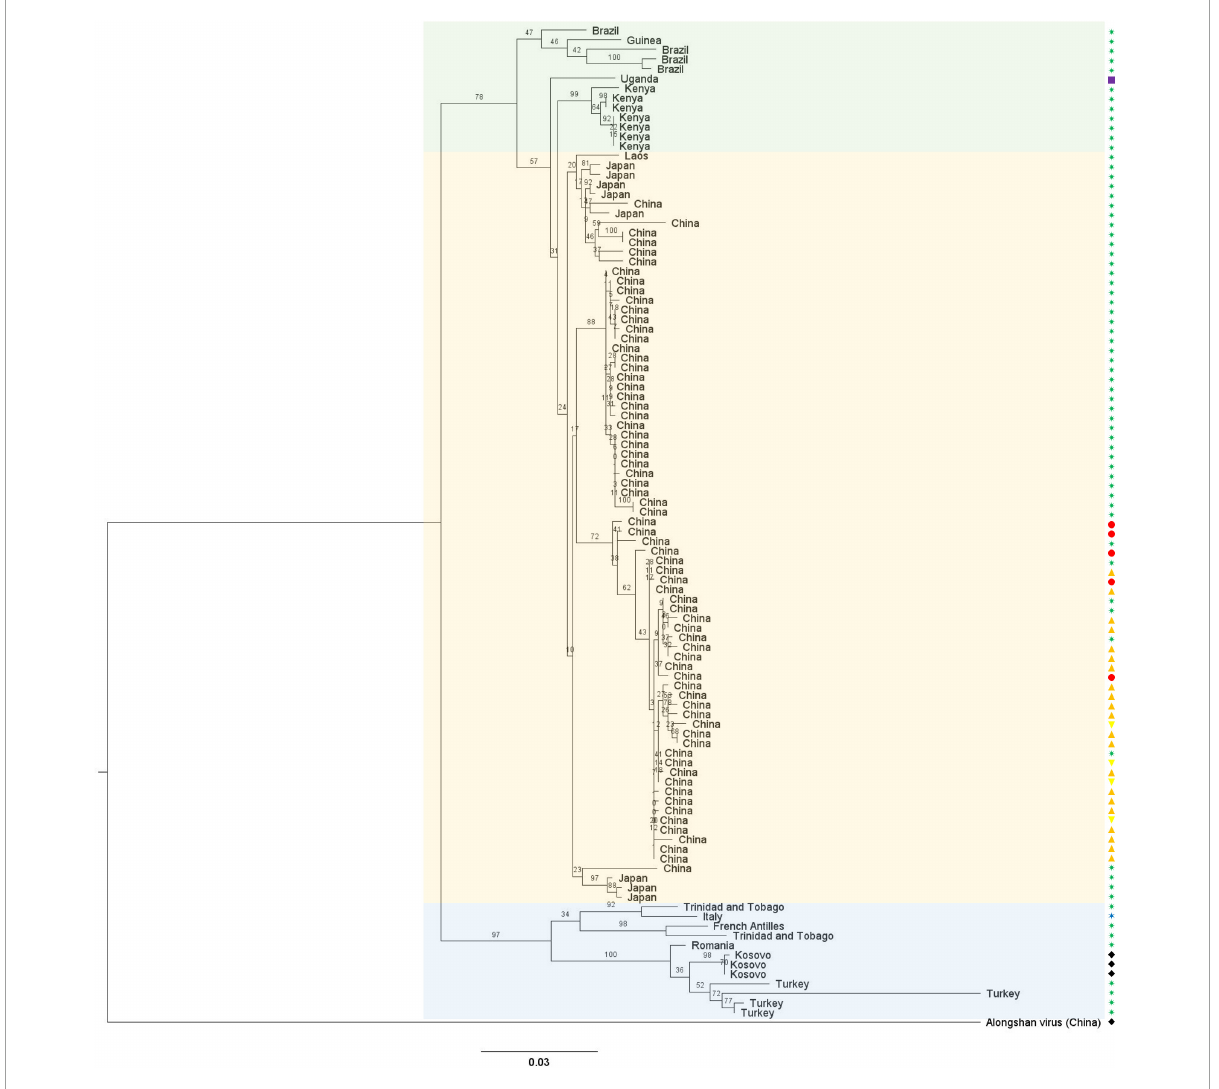
FIGURE4 Phylogenetic analysis of all published full-length NSP1 ORF amino acid sequences of JMTV strains, and the prototype strain of ALSV as an outgroup. This tree was built with PhyML with an LG substitution model and midpoint-rooted. The branches are labeled with the bootstrap proportion in percentages (out of 100 bootstraps), the tips are labeled with the sample collection location, and the bar represents 0.03 substitutions per nucleotide position. JMTV strains seem to cluster according to their detection location rather than host with two clear subclades, the European and Central American strains (shaded in blue) on one side and the Asian (shaded yellow) and African and South American (shaded green) strains on the other side. The hosts are represented with symbols on the side of the phylogenetic tree: ticks are green stars with eight branches, mosquitoes are blue stars with six branches, monkeys are purple squares, cattle are red circles, bats are orange triangles pointing up, rodents are yellow triangles pointing down and humans are black